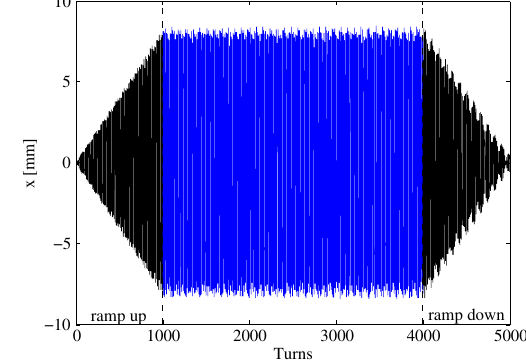
FIG. 1. Typical excitation pattern of a driven oscillation at frequency Q d as simulated in HEADTAIL.